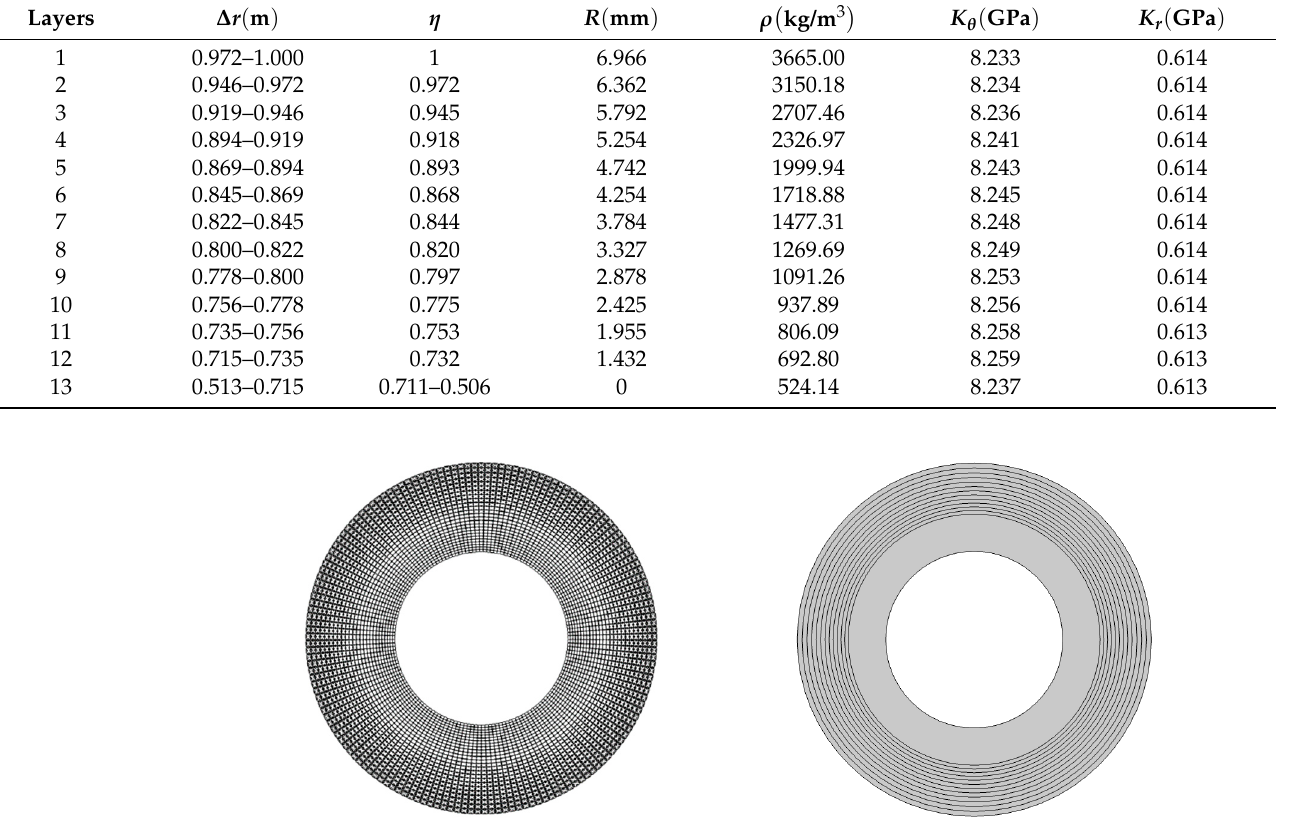
Figure 11. Pentamode material acoustic stealth cloak structure: ( a ) actual structure; ( b ) homogenization structure.